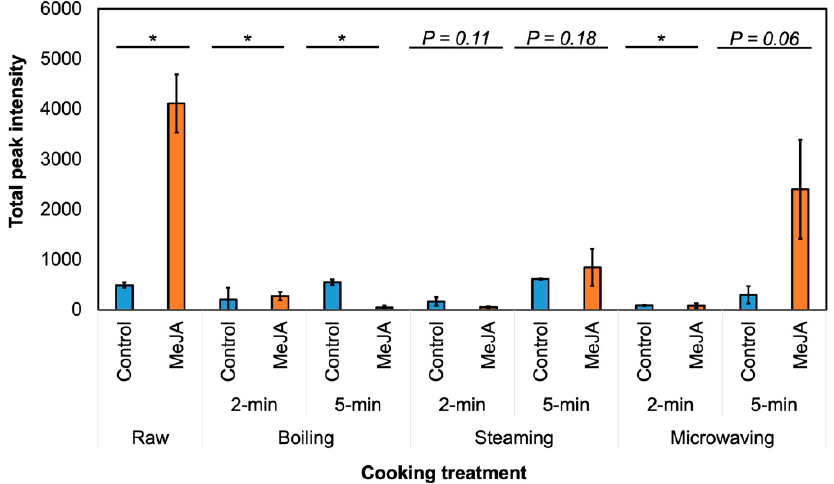
Figure 4. Total peak intensity of glucosinolate hydrolysis products in raw and cooked broccoli. MeJA, broccoli with 250 µM methyl jasmonate treatment. Asterisk (*) = significant difference with or without MeJA by Student’s T-test ( p ≤ 0.05, n = 3) under the same cooking conditions. ns , *, p ≤ 0.05.